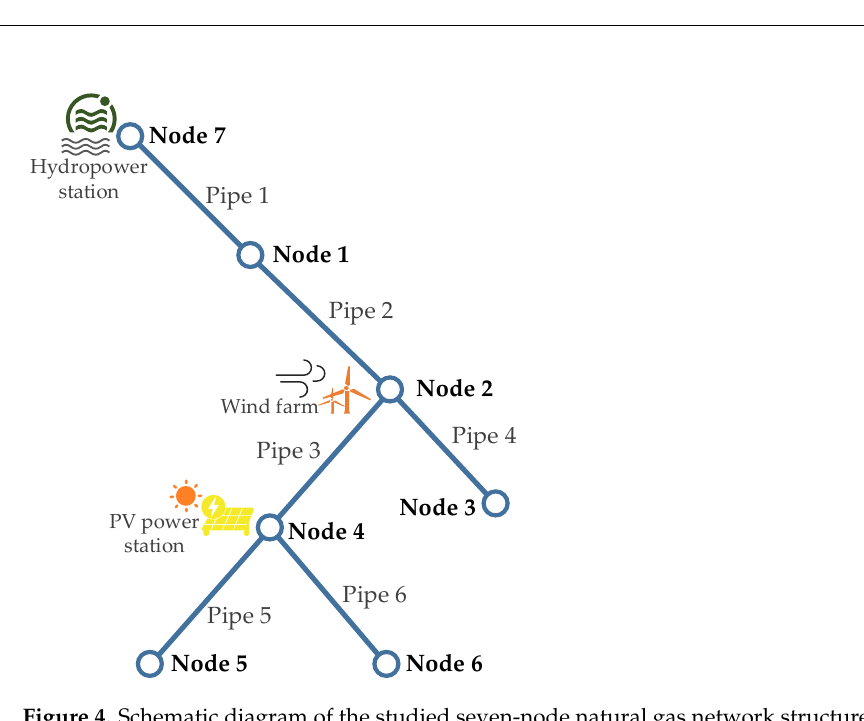
Figure 4. Schematic diagram of the studied seven-node natural gas network structure.